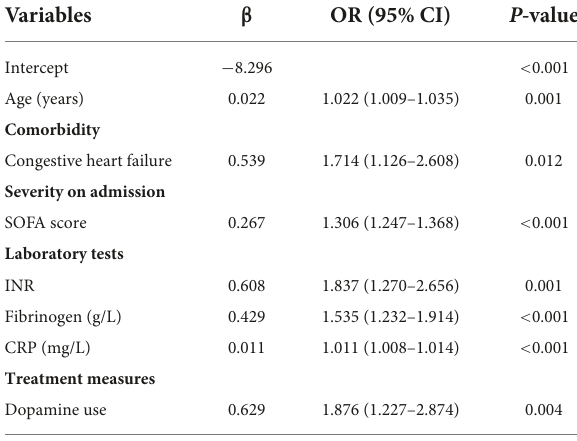
TABLE 2 Association between risk factors and new-onset atrial fibrillation in multivariate logistic